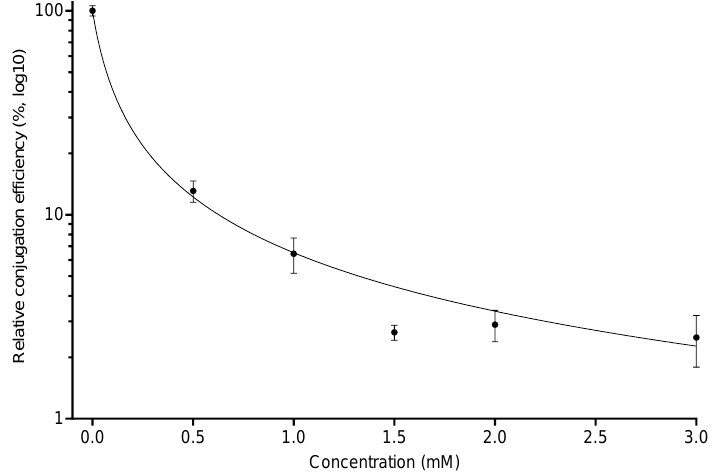
Figure 2. CuSO 4 lowers conjugation efficiency proportional to the concentration added. Cultures of the donor (HA14) and recipient strain (HA4) were grown to log phase and then mixed and allowed to mate in the presence of various concentrations of CuSO 4 for 30 min. Conjugation efficiency was calculated as in Figure 1 and as described in Materials and Methods. Symbols indicate the mean and error bars and represent the standard error of the mean (SEM) of 2 biological replicates with 2 technical replicates each.